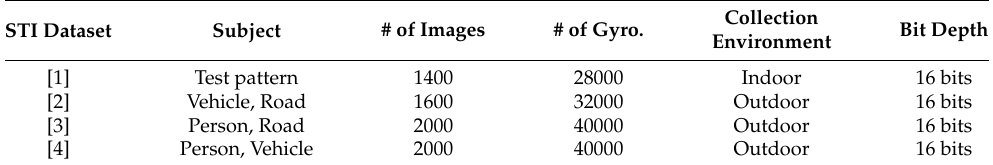
Table 2. Configuration of STI